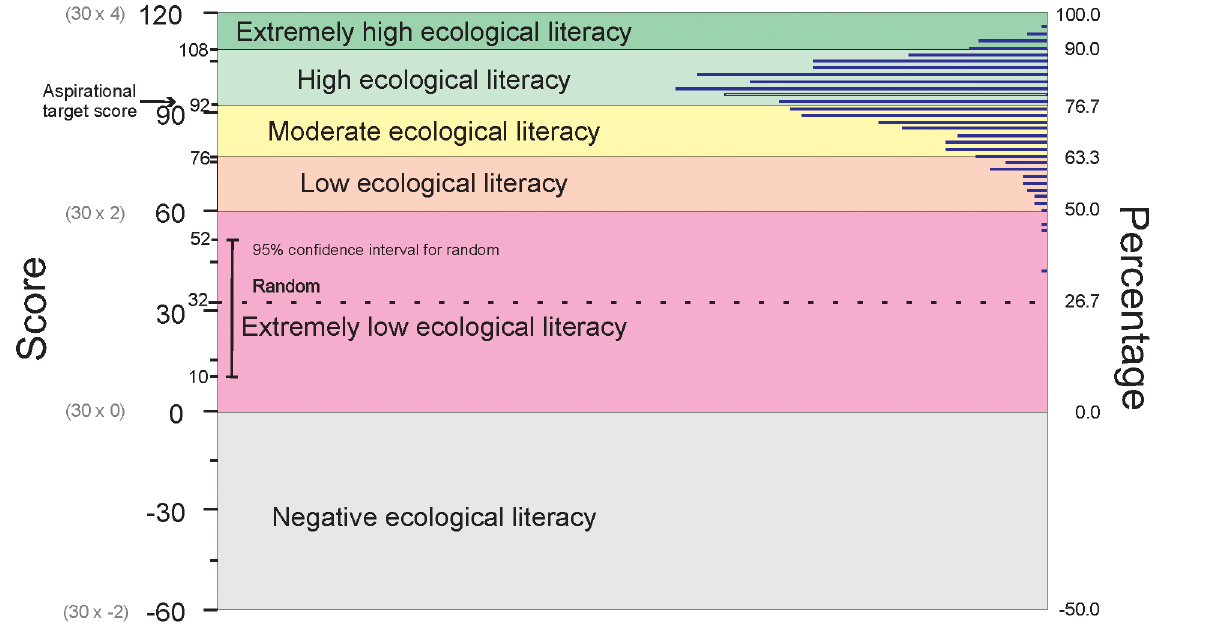
Fig 3. The total range of 1,010 valid data sets distributed within the eco-literacy standards